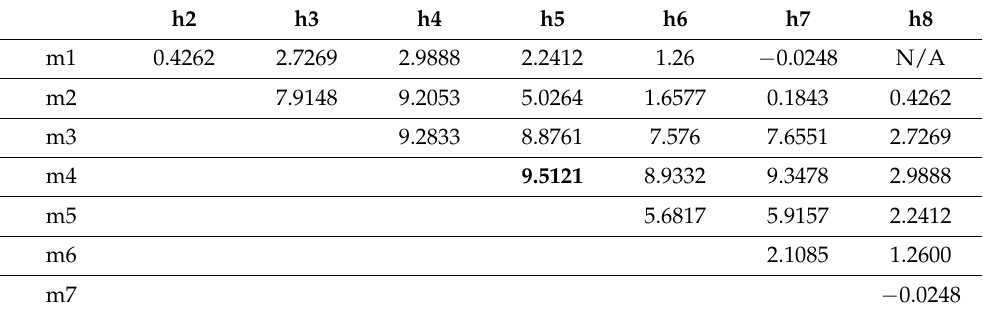
Table 12. Log-rank statistics for matching the C 2 HEST risk strata for all-cause hospital mortality in CAD cohort. h2 h3